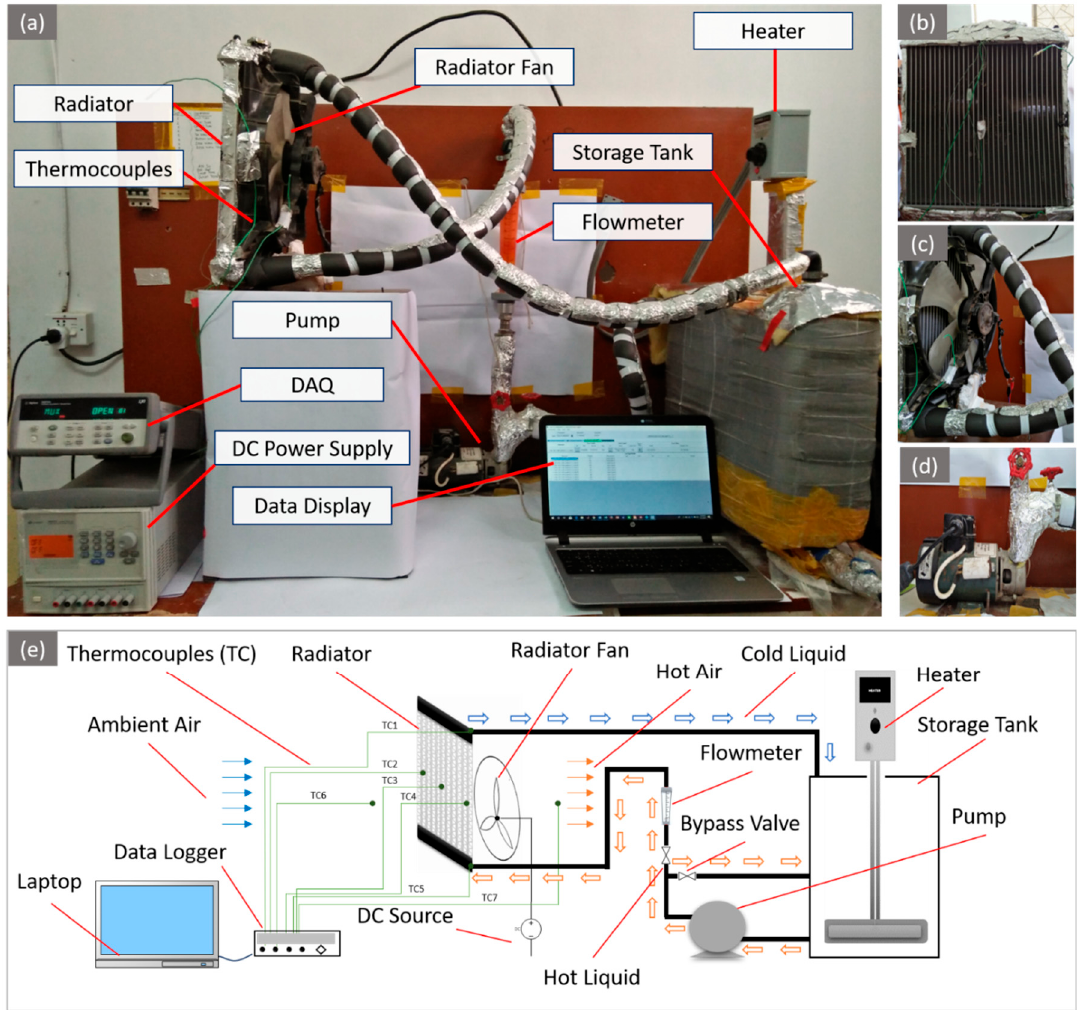
Figure 4. Experimental setup: equipment arrangement ( a ), aluminum tube radiator ( b ), radiator fan ( c ), centrifugal pump ( d ), and schematic illustration ( e ).